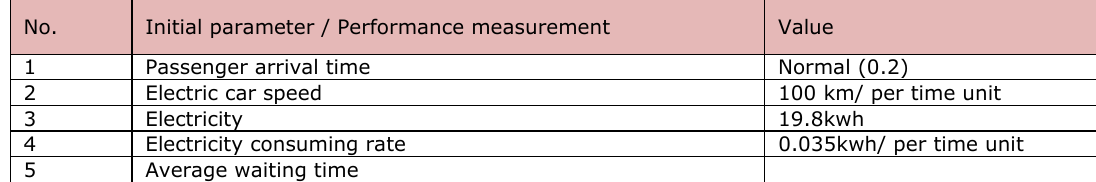
Table 5. “Initial parameters and Performance measurement in the electric taxi DAR operation